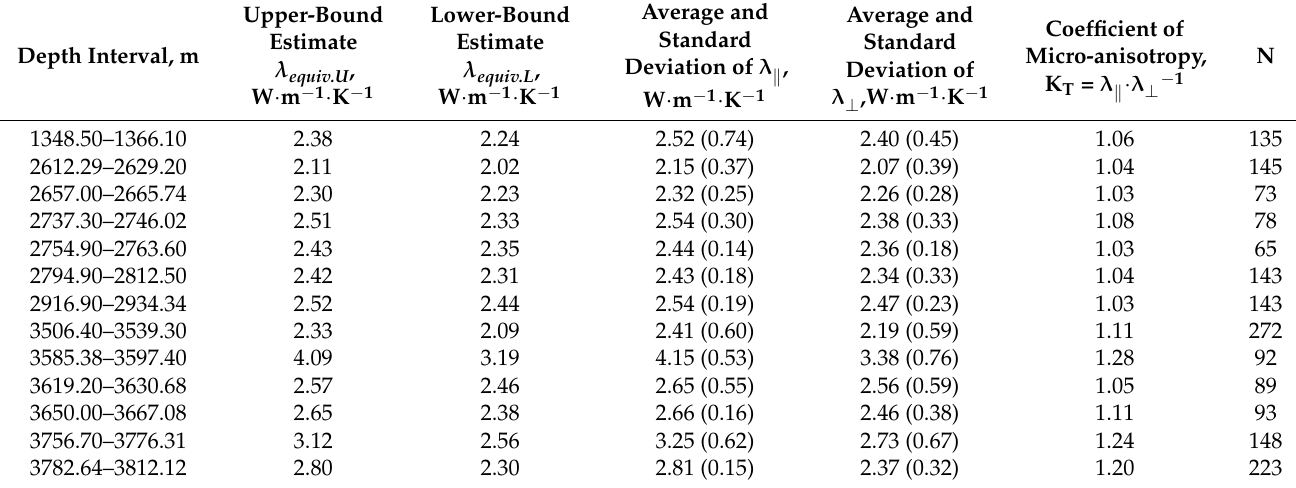
Table 4. Results of the experimental determination of the equivalent thermal conductivity along the vertical axis of the well under study for the investigated depth intervals using the results of the continuous thermal core logging of full-sized cores in an “as-received” state and atmospheric